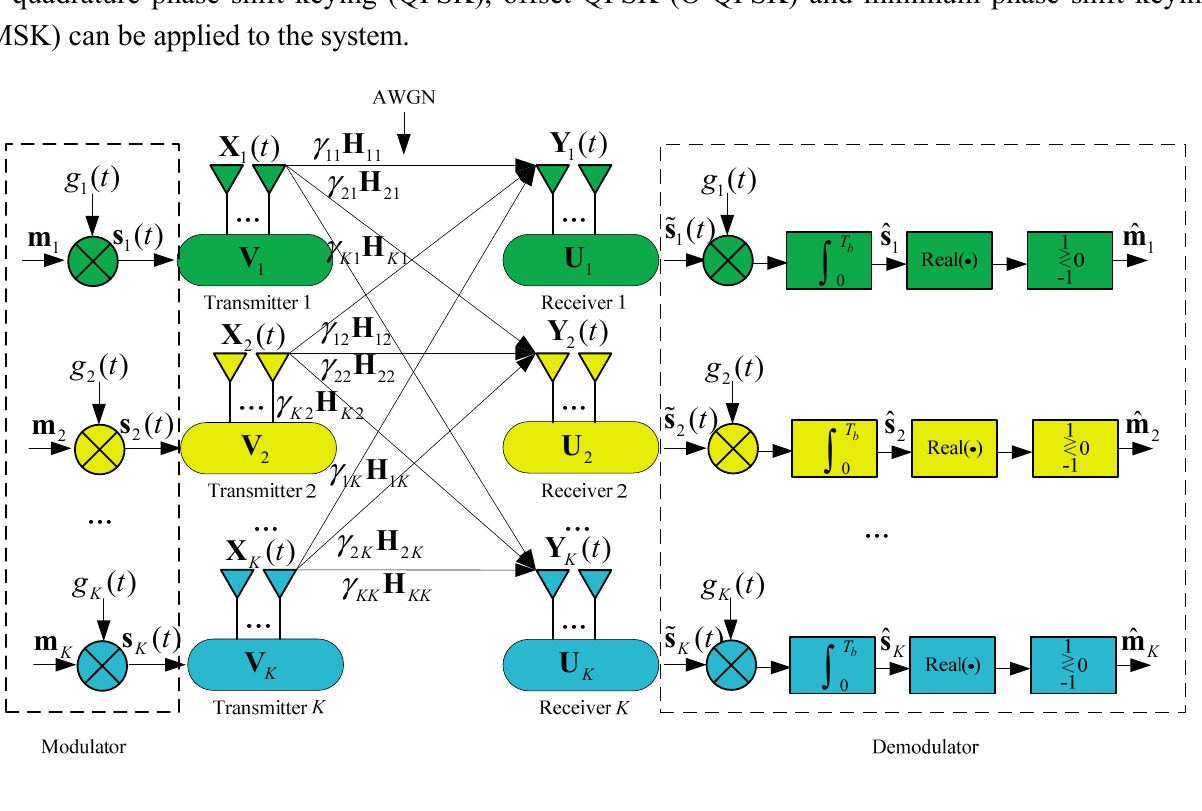
Figure 1. The BPSK transmission system in the K -user MIMO interference